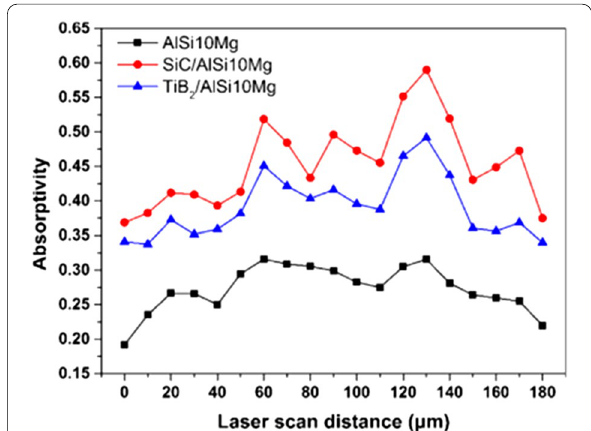
Figure 3 Laser absorptivity along the beam path of pure AlSi10Mg, SiC/AlSi10Mg and TiB 2 /AlSi10Mg [25]